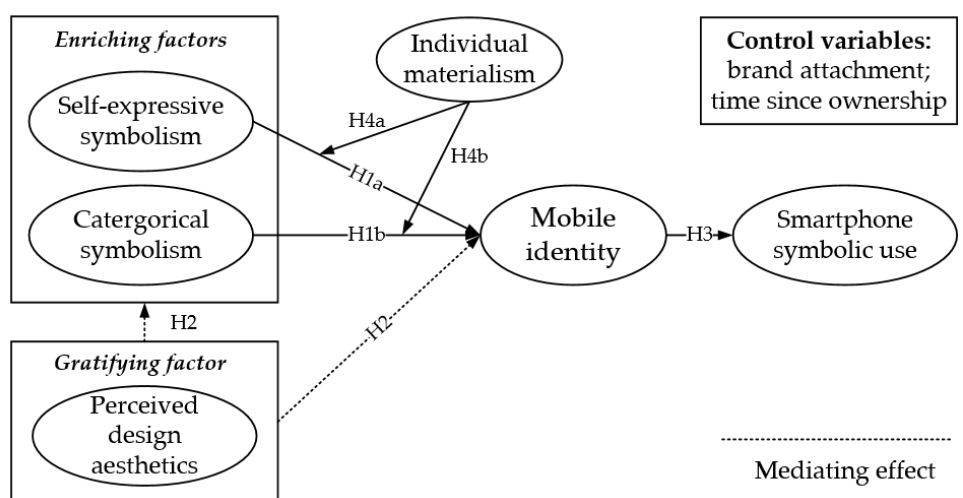
Figure 3. Research model of the effects of mobile identity on smartphone symbolic use.